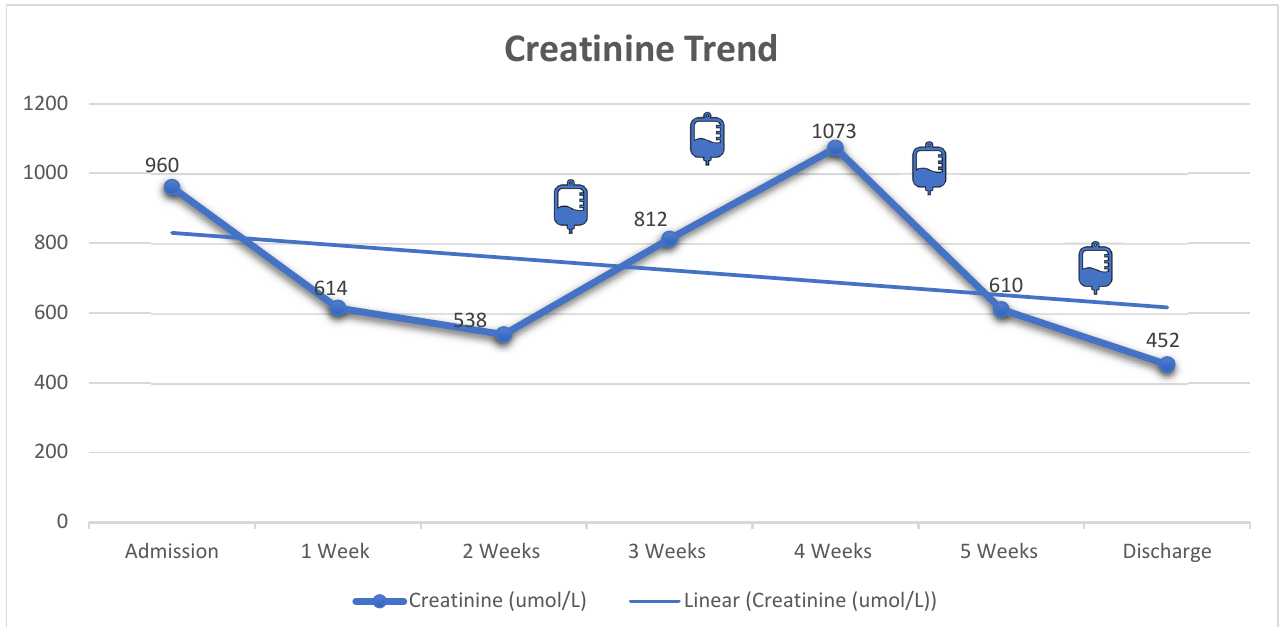
Figure 2. Trend of hemoglobin level during hospital course. The infusion bag icons correlate with the time of each rituximab dose. The patient had a signi fi cant drop in his hemoglobin level (41 gm/L) with perinephric hematoma post renal biopsy. Therefore, the left renal artery was successfully em- bolized, resulting in signi fi cant improvement in the patient’s hemoglobin level (101 gm/L). RB: renal biopsy.